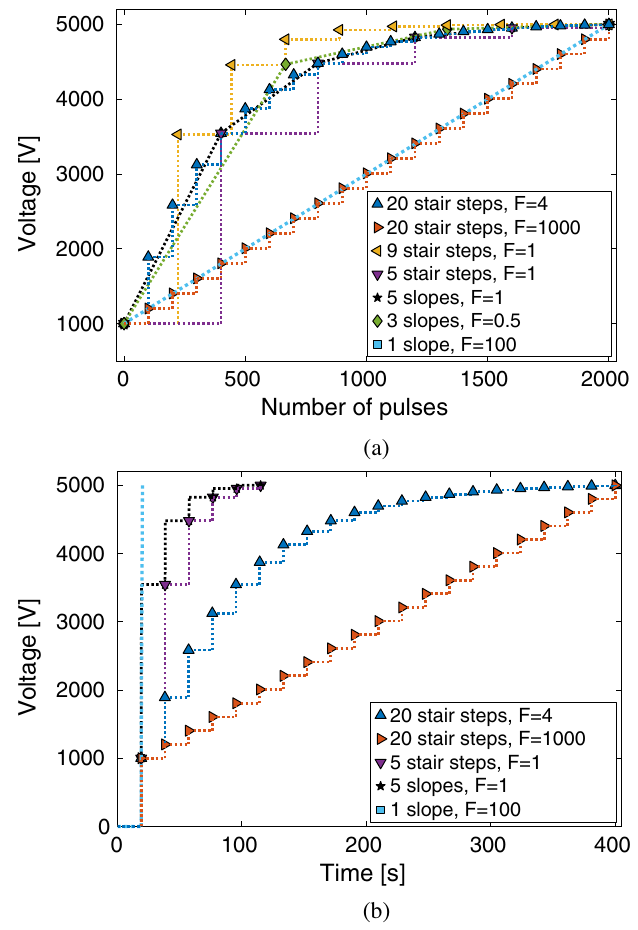
FIG. 2. (a) Comparison of five different ramping scenarios with ¼ voltage against number of pulses following Eq. (1) with V target 5000 V and V ¼ 1000 V (ramping factor 1 ). Each marker 5 start represents the voltage at the beginning of each ramping step or slope. A 20-s pause (idle time) in the system always precedes the pulse with the marker. (b) The selected scenarios with respect to elapsed time after the previous breakdown. In the beginning of each step, there is a fraction of a second of pulsing followed by nearly 20 s of idle time during which the voltage change is performed. The voltage increase in the slope scenarios is not instant but takes place during this fraction of a second, and, thus, the slope is not really visible in the